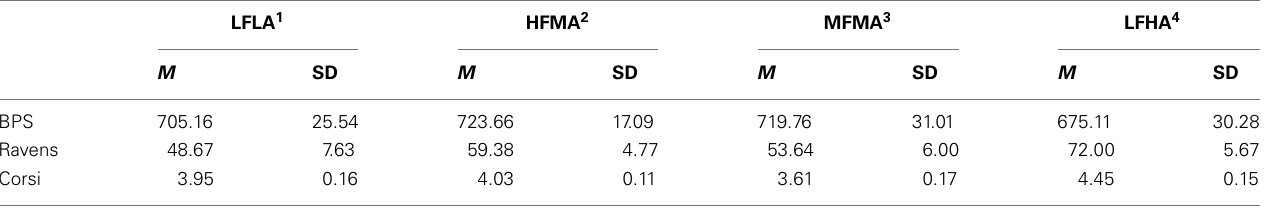
Table 5 | Reaction time, Ravens and Corsi measures as a function of SDA finger-use subgroup.